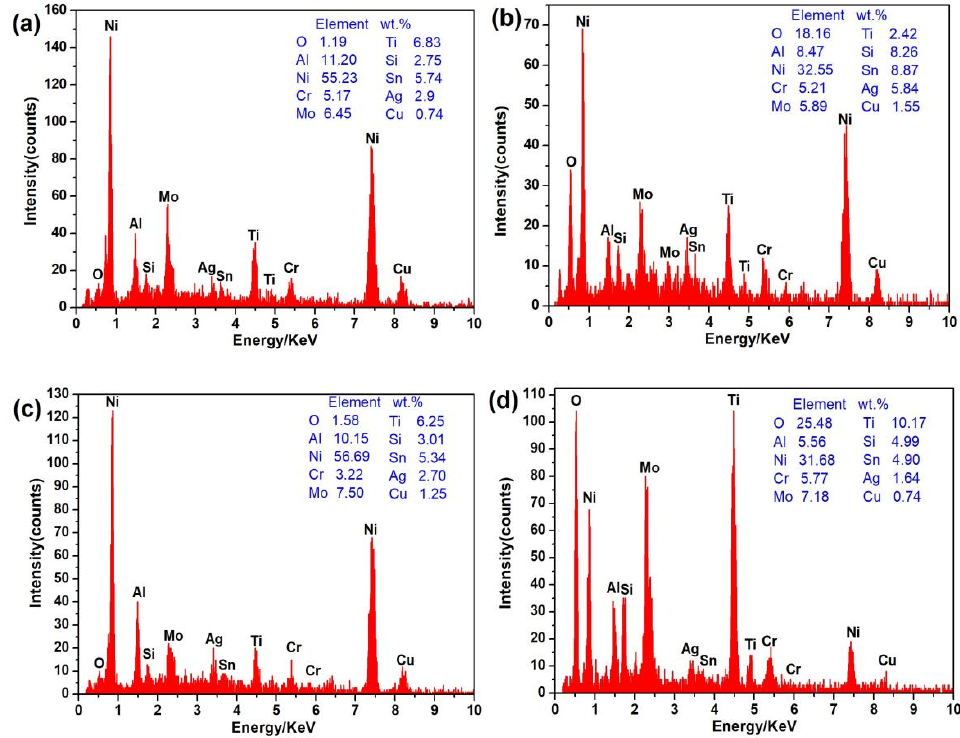
Figure 14. EDS profiles of the box labeled areas presented in Figure 13b,d: area A ( a ), area B ( b ), area C ( c ) and area D ( d ).